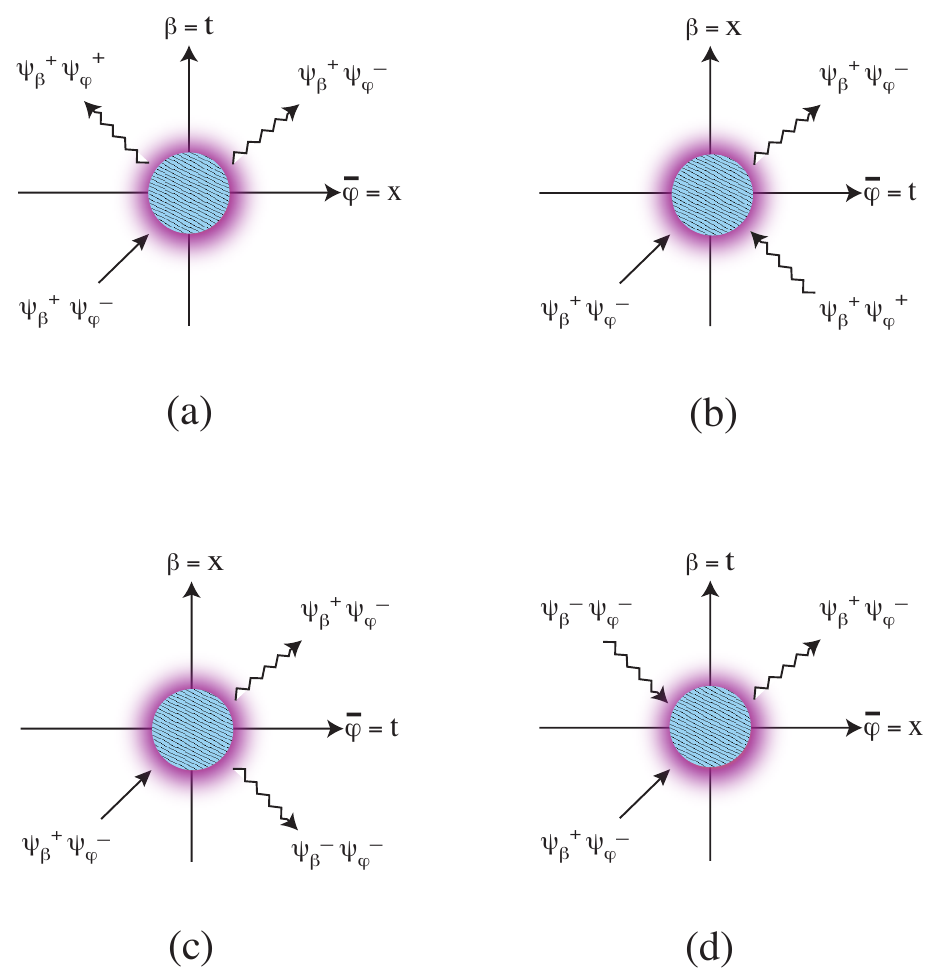
Figure 1. Four different classes of scattering processes for the incoming wave function describing a phase of expanding pre-big bang evolution, asymptotically emerging from the string perturbative vacuum (straight, solid line). The outgoing state is represented by a mixture of eigenfunctions of Π β and Π with positive and negative eigenvalues. See the main text for a detailed explanation of the four different cases ( a – d ) illustrated in this